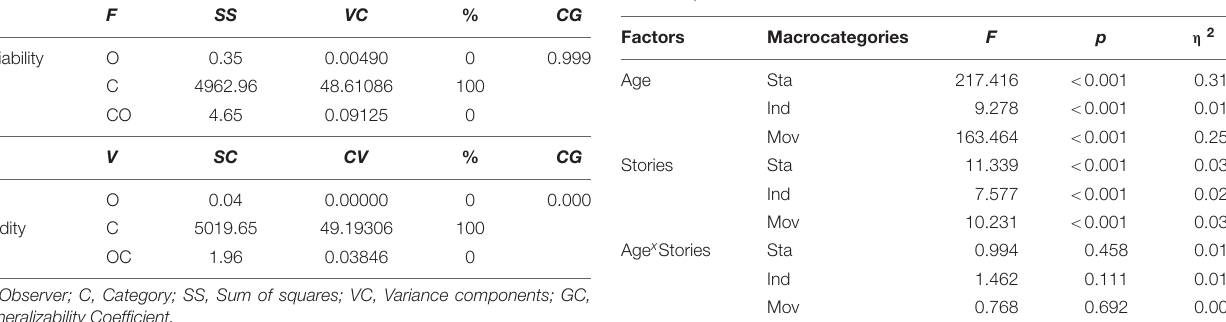
TABLE 4 | Multivariate linear analysis of macrocategories: static, indication, and